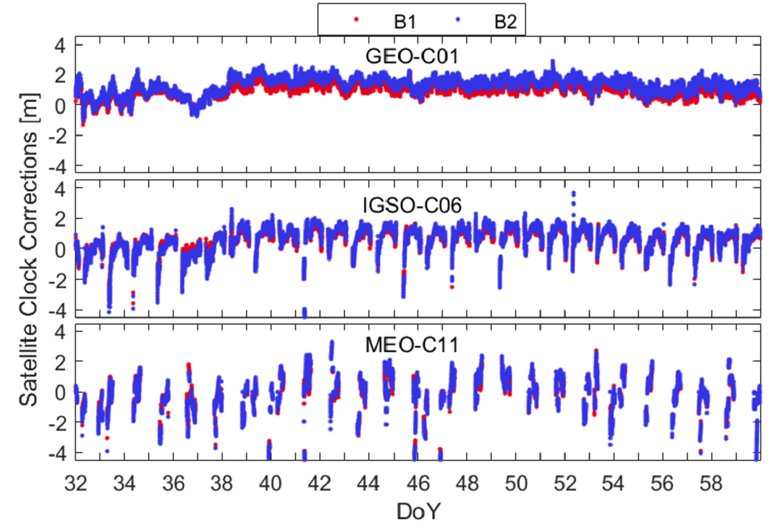
Figure 3. One-month BDS real-time clock correction time series for C01, C06, and C11. Table 2. Statistics of BDS real-time clock correction time series for C01, C06, and C11 (in meter).